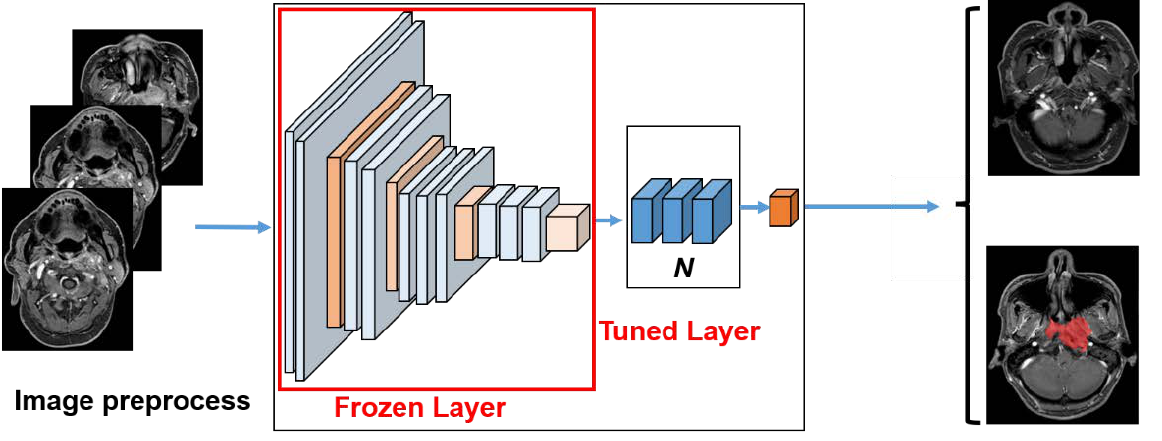
5 of 16 Figure 2. The schematic figure of the model. The following CNN-based models are evaluated.